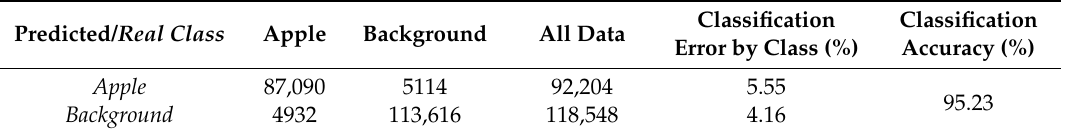
Table 8. Confusion matrix and accuracy of the segmentation algorithm using neural networks on the test set.